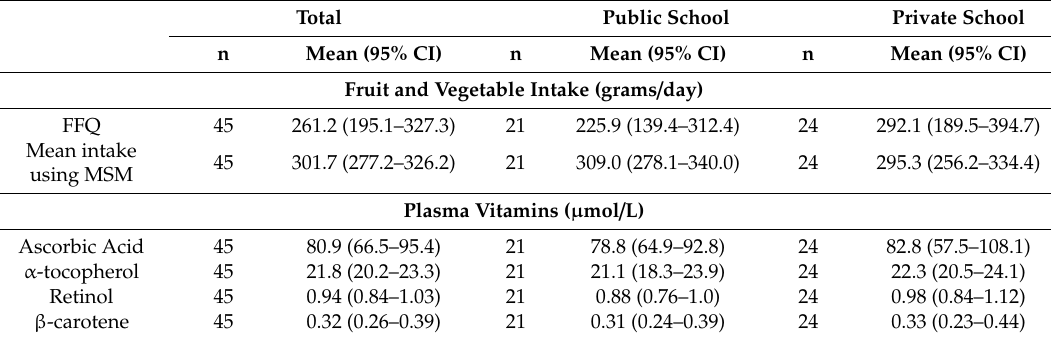
Table 2. Fruit and vegetable intake and plasma vitamins concentration in a subsample of children (6–10 years) from the SAYCARE Study. S ã o Paulo, Brazil. 2017.